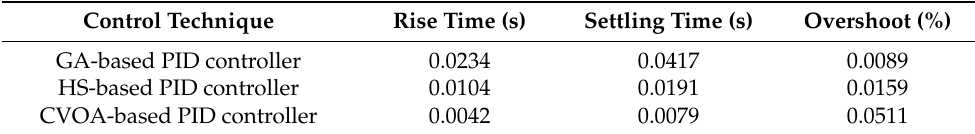
Table 4. The performance of each control technique.